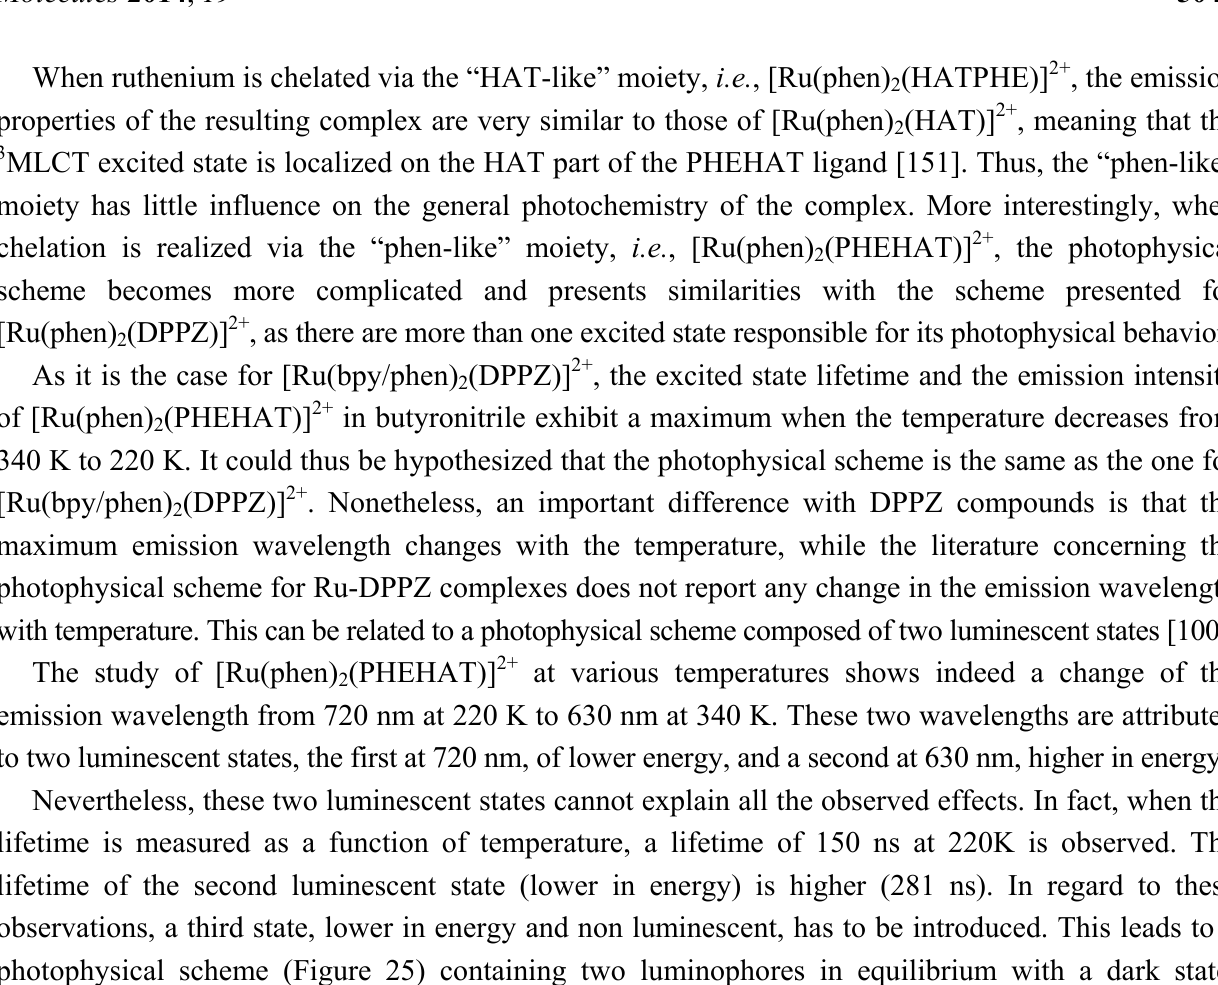
Figure 25. Photophysical scheme for [Ru(phen)